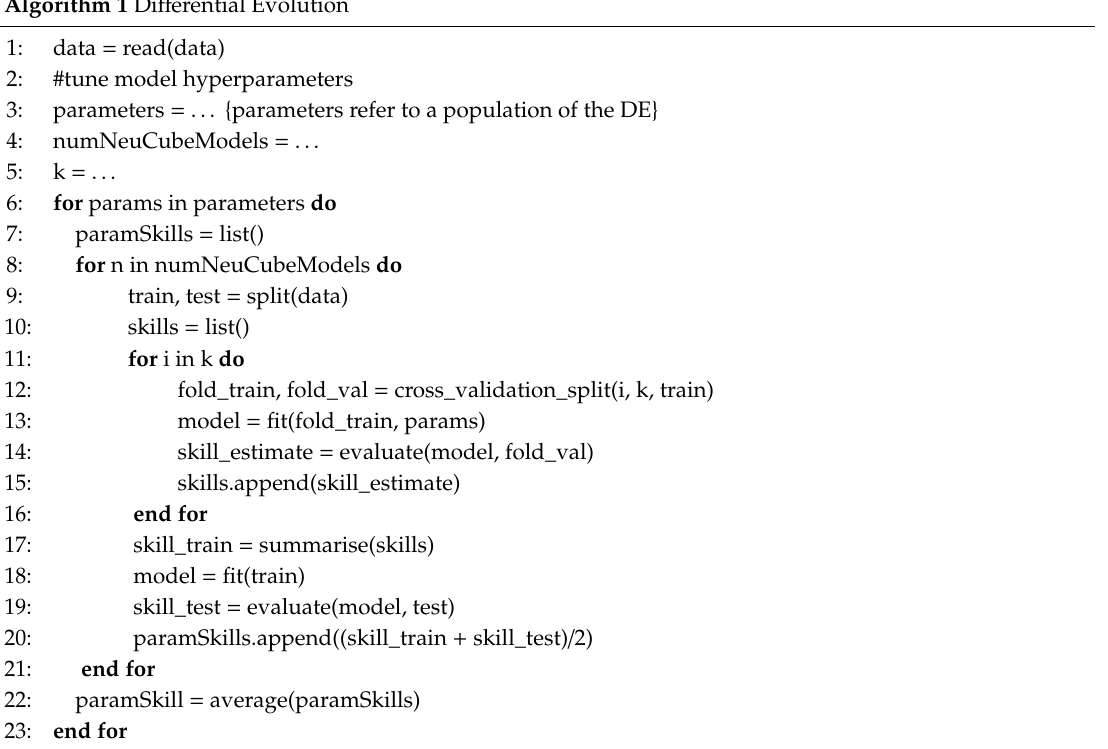
Algorithm 1 Di ff erential